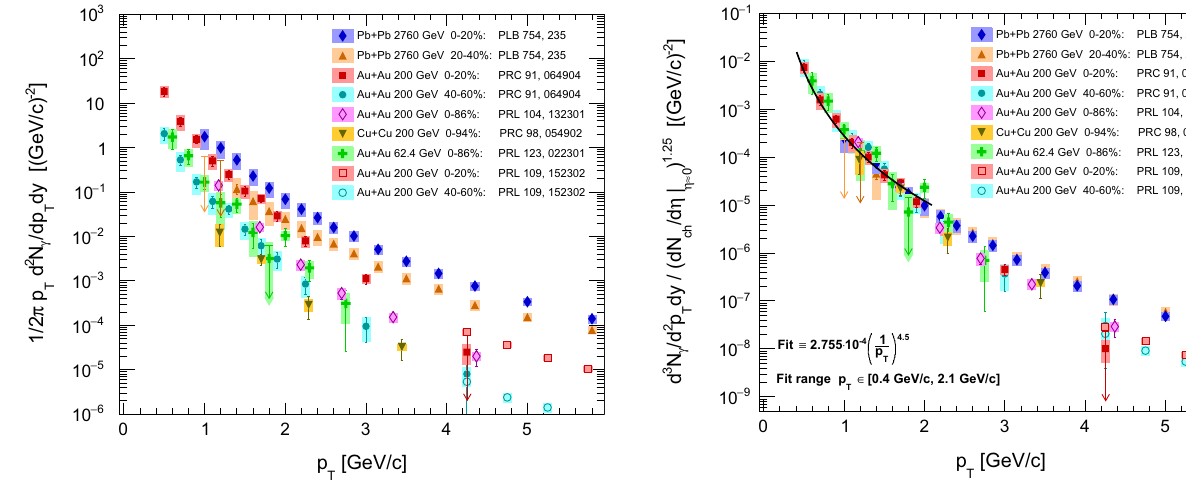
Fig. 2 Direct photon p T -spectra from Fig. 1 scaled by ( dN ch / d η) 1 . 25 . The black curve corresponds to a power-law fit, the details of which are shown in the plot. See the next sections for more